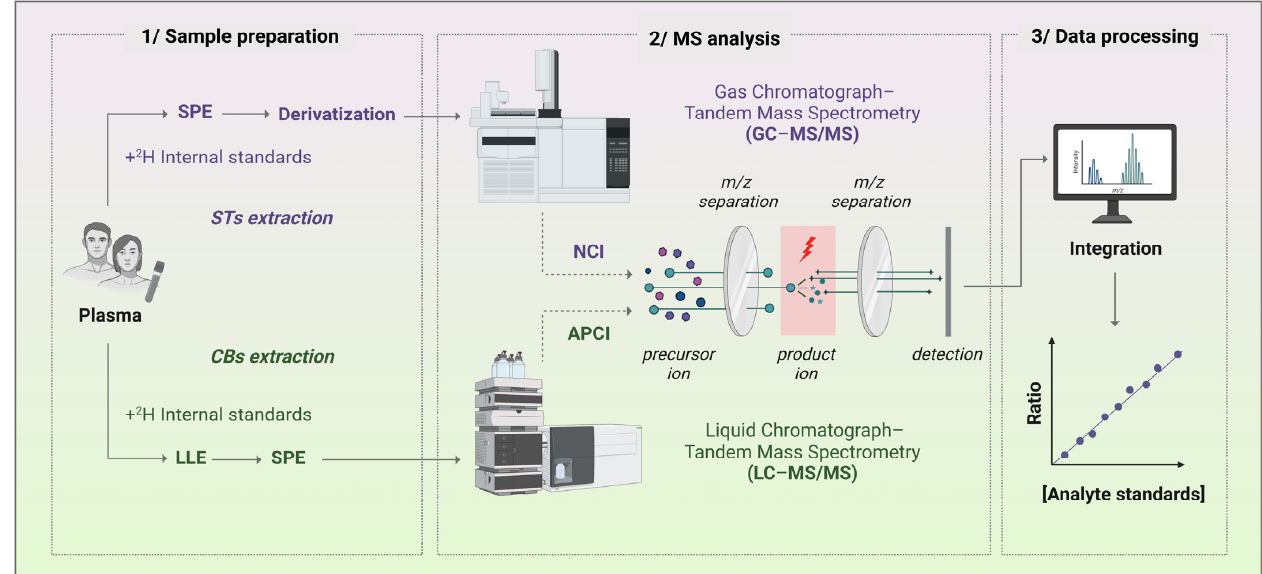
Figure 4. Routine analytical workflow in biological samples. 1/Sample preparation involved the addition of deuterated ( 2 H) ‐ labelled internal standards (ISs) to samples prior to solid phase extraction (SPE) and derivatization processes for steroids (STs) or prior to liquid–liquid and solid phase extraction (LLE and SPE) steps for cannabinoids (CBs). 2/NCI GC ‐ MS/MS and ACPI LC ‐ MS/MS analyses were performed for STs and CBs, respectively. Both tandem MS included m / z separation for selective precursor and product ions of each analyte for detection. 3/Data processing required peak integration of the targeted analytes and their respective ISs, and quantification based on an analyte calibration curve obtained from the analyte ‐ to ‐ IS ratio of peak intensities for increasing concentrations of analyte standards.